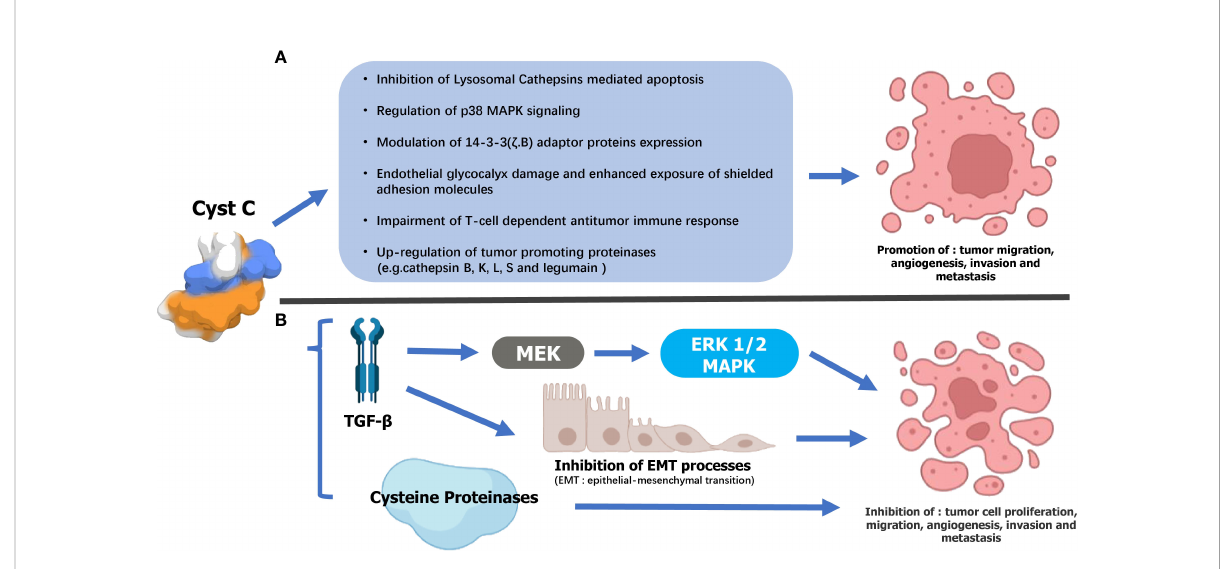
FIGURE 2 Supposed mechanisms underlying the dual opposing effects of Cystatin C (Cyst C) on urogenital malignancy progression. (A) Tumor- suppressing mechanisms 1) Cathepsin inhibition-dependent: Cyst C may thwart urogenital malignancy progression by inhibiting extracellular cysteine cathepsin activity and, consequently, their contribution to tumor cell migration, invasion, angiogenesis, and metastasis. 2) TGF- b interaction: Cyst C inhibited TGF- b binding to its type II cell surface receptor as well as TGF- b stimulation of initiating metastatic events such as epithelial-to-mesenchymal transition (EMT). 3)Cyst C may also mediate tumor cell invasion by regulating the MAPK/ERK cascade. (B) Cyst C may promote the malignant progression of urogenital malignancy by 1) inhibiting Lysosomal Cathepsins-mediated apoptosis. 2)Regulation of p38 MAPK signaling. 3)Modulation of 14-3-3 ( z .B) adaptor proteins expression. 4) Damage to the endothelial glycocalyx and increased exposure of shielded adhesion molecules. 5) Impaired antitumor immune response mediated by T cells. 6) Increased expression of tumor-promoting proteinases (for example, cathelipsin B, K, L, S, and